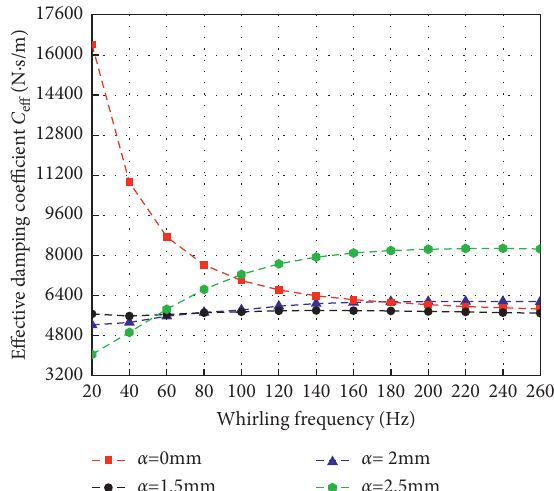
Figure 15: Effective damping coefficient vs. whirling frequency.